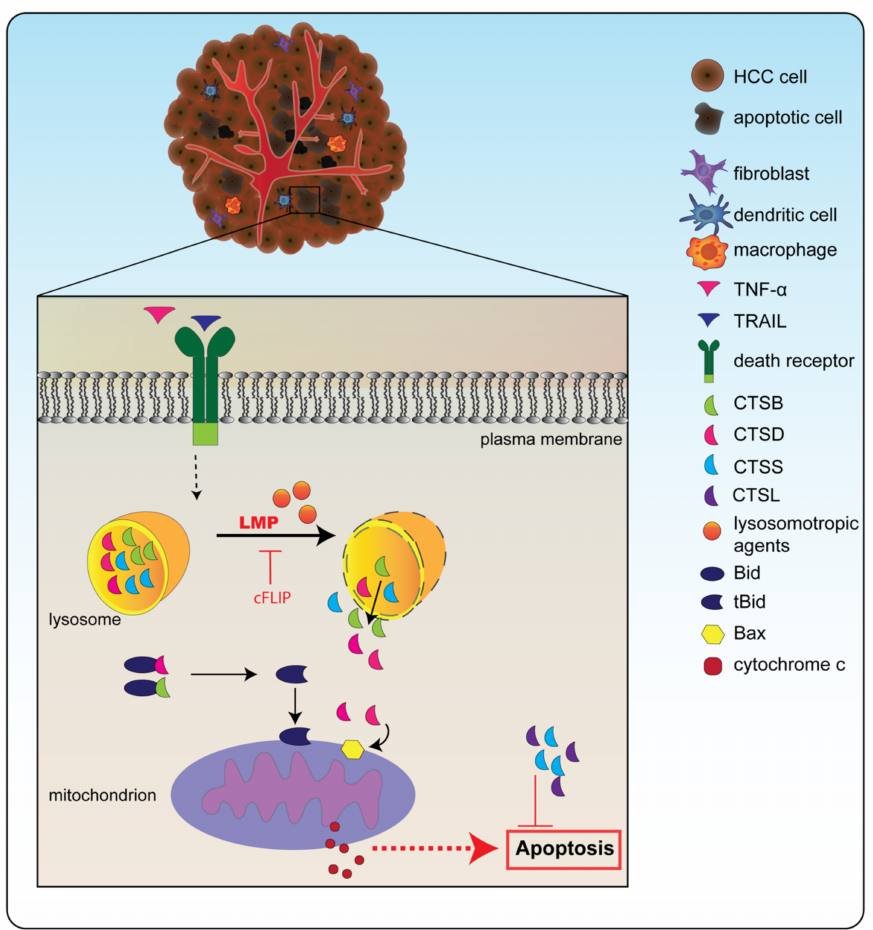
Figure 1. Cathepsins are involved in apoptosis. Destabilization of the lysosome through factors such as TNF-related apoptosis-inducing ligand (TRAIL) or tumor-necrosis factor α (TNF- α ) combined with a lysosomotropic agent leads to lysosomal membrane permeabilization (LMP). Through LMP, cathepsins can be released from the lysosome into the cytosol. In the cytosol, cathepsin B (CTSB) and cathepsin D (CTSD) can cleave pro-apoptotic factor Bid into its active version truncated (t)Bid. In addition, these cathepsins can stimulate Bax insertion into the mitochondrial membrane. Together, this leads to the release of cytochrome c, which can induce the caspase cascade, eventually culminating in apoptosis. Cathepsin S (CTSS) and cathepsin L (CTSL), however, can inhibit apoptosis and therefore when they are upregulated, cancer cells can resist this form of cell death. Note: the mechanisms of cathepsin-induced apoptosis are most likely similar to the mechanisms occurring in